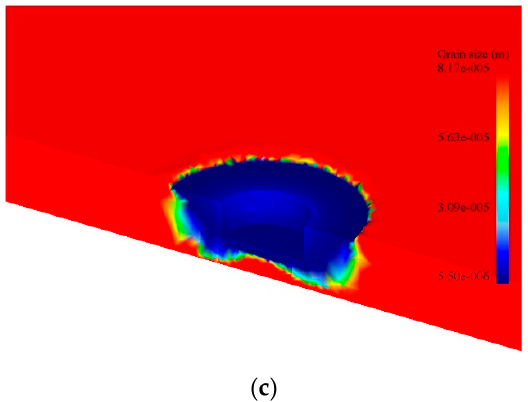
Figure 14. Grain size distribution at different stages of FSSW: ( a ) plunging stage; ( b ) at the moment of shoulder contact with workpiece; ( c ) at the end of the welding process. (FSSW parameters: rotating speed 1600 rpm, plunge rate 72 mm/min, plunge depth 2.2 mm, and dwell time 3 s).